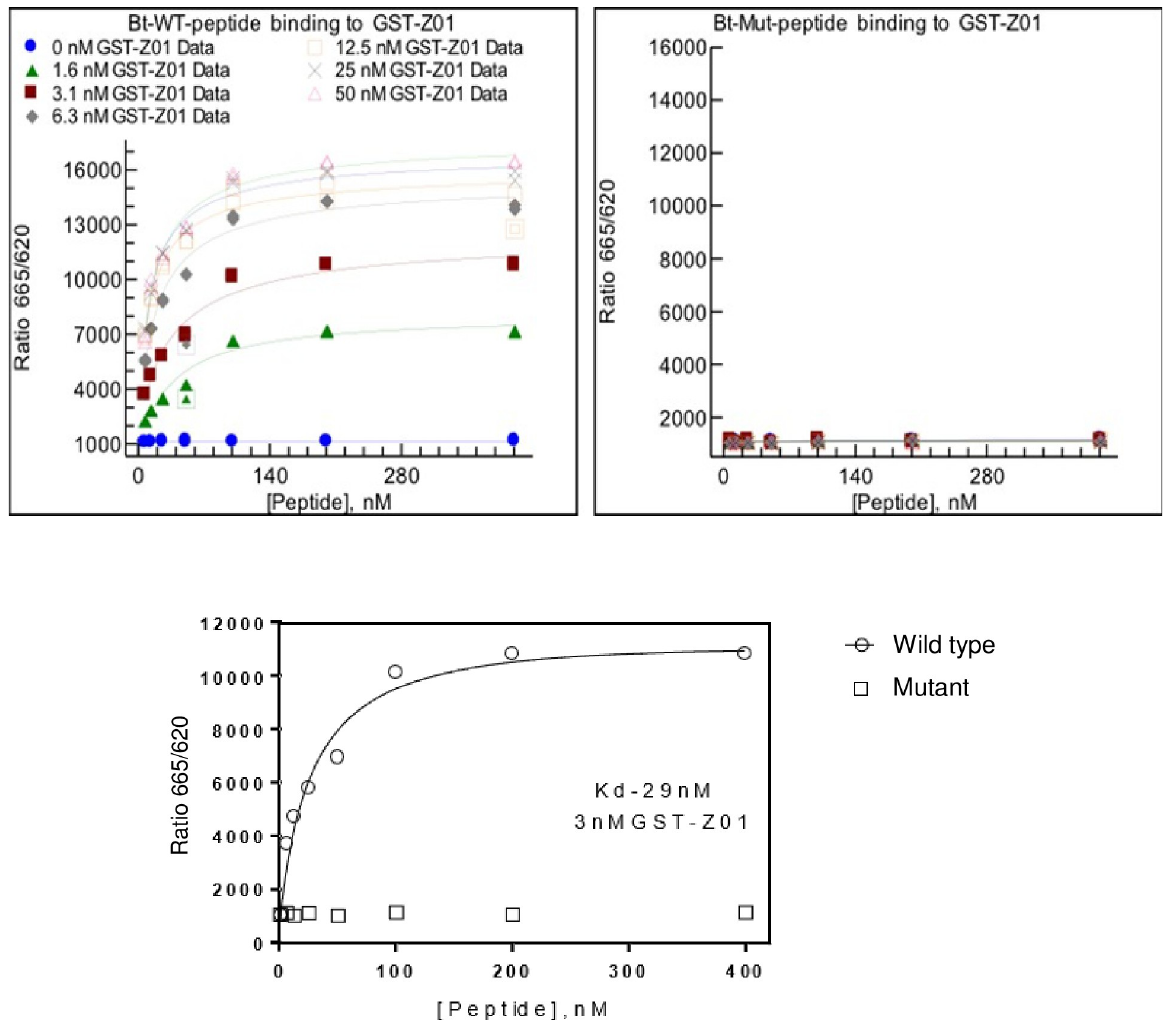
Fig 3. Homogenous Time Resolve Fluorescence (HTRF). The concentration dependent binding properties of SARS-CoV-2 E-WT (Bt-WT peptide, left panel) and E-mutant (Bt-Mut peptide, right panel) peptides with purified GST-PDZ domain #2 of ZO1 are shown. Concentrations of the GST-PDZ domain fusion protein ranging from 0–50 nM (indicated by the various symbols) were incubated with the indicated concentrations of E-WT (left) or E-mutant (right) peptides (x-axis), and the HTRF signal was measured. The E-WT peptide did not bind to GST alone (left panel, blue dots); however, clear concentration dependent binding of the E-WT peptide to GST-PDZ domain 2 of ZO1 was observed. The E-mutant peptide did not bind to any concentration of GST-PDZ domain 2 of ZO1 tested (right panel). A Kd value of 29nM was calculated for E-WT peptide binding to 3nM concentration of GST-ZO1 PDZ domain #2 (bottom panel).